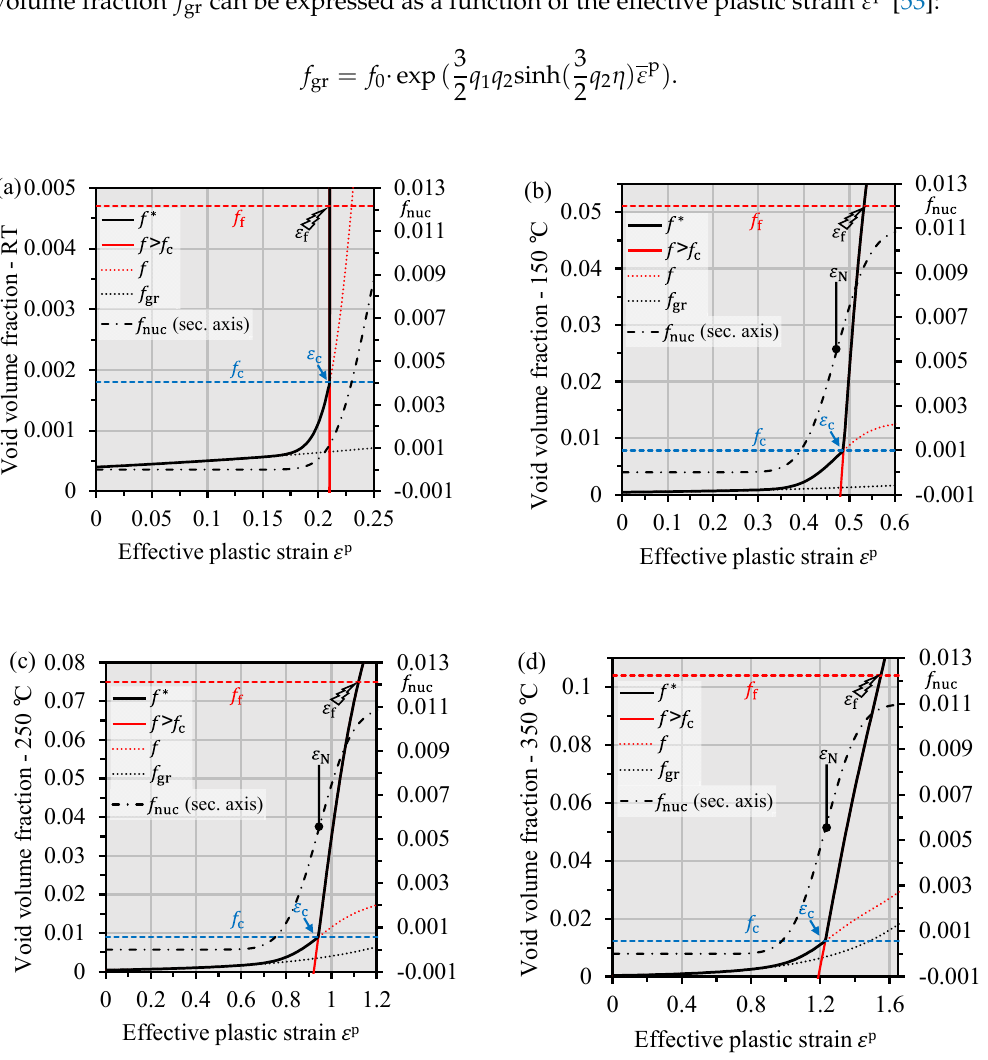
Figure 11. Void volume fractions after calibration of the growth parameters for the temperatures RT ( a ), 150 °C ( b ), 250 °C ( c ), and 350 °C ( d ) to fit experimental data taken according to Figure 2 from notched samples.